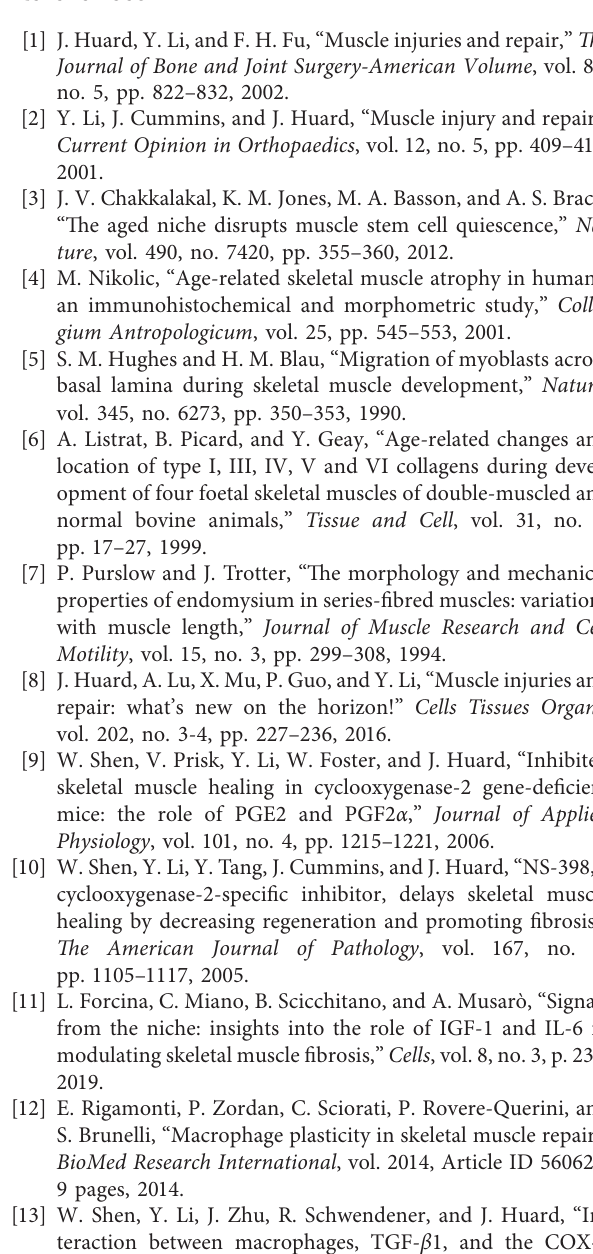
Figure 2: The timeline of muscle healing processes and therapeutic potential